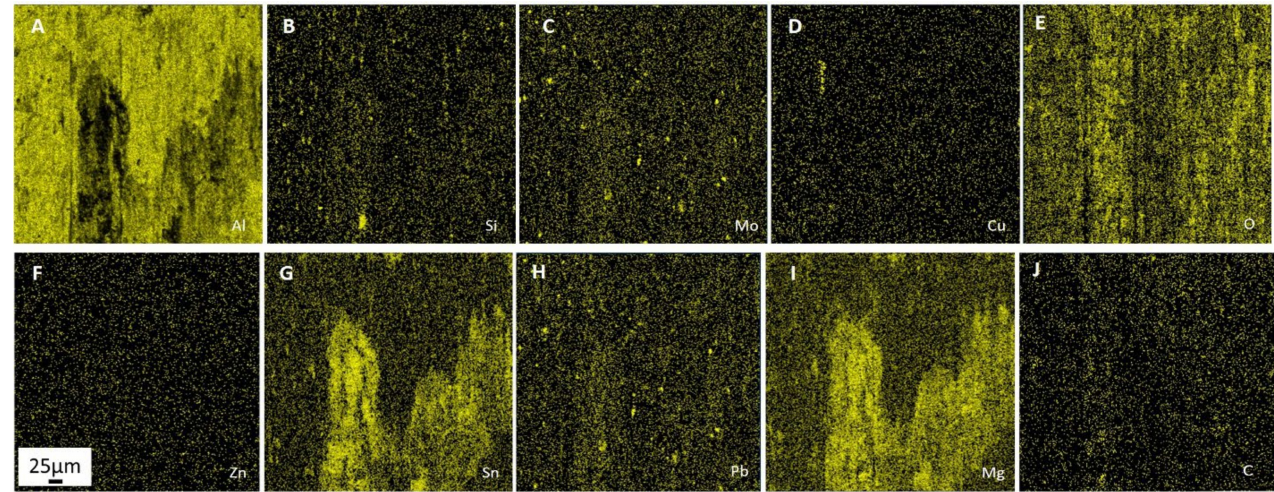
Figure 7. SEM-EDS maps of elemental distributions on the Al–Mo alloy worn surface for aluminum ( A ), silicon ( B ), chromium ( C ), copper ( D ), oxygen ( E ), zinc ( F ), tin ( G ), lead ( H ), magnesium ( I ) and carbon ( J ). The scale in Figure F also applies to rest of images (scale: 25 µ m). Table 10 below shows the 32 EDS points analysis data and the concentration of the ele- ment in the Al–Mo composition in accordance with the scheme presented in Figure 6B. Table 10. EDS chemical identification of elements and their concentration in Al–Mo alloy worn surface.